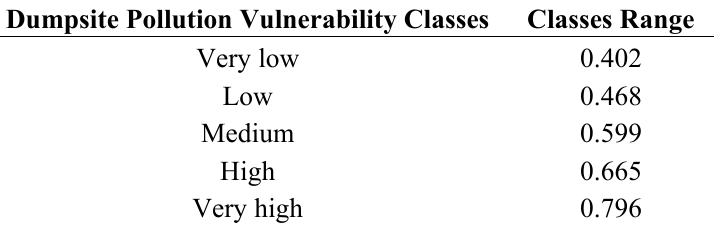
Figure 15. Cumulative frequency curve of risk classes (fuzzy logic method). Table 4. Range classes of dumpsite pollution risk (fuzzy logic method).